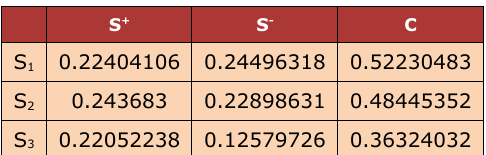
Table 8. Relative closeness to the ideal